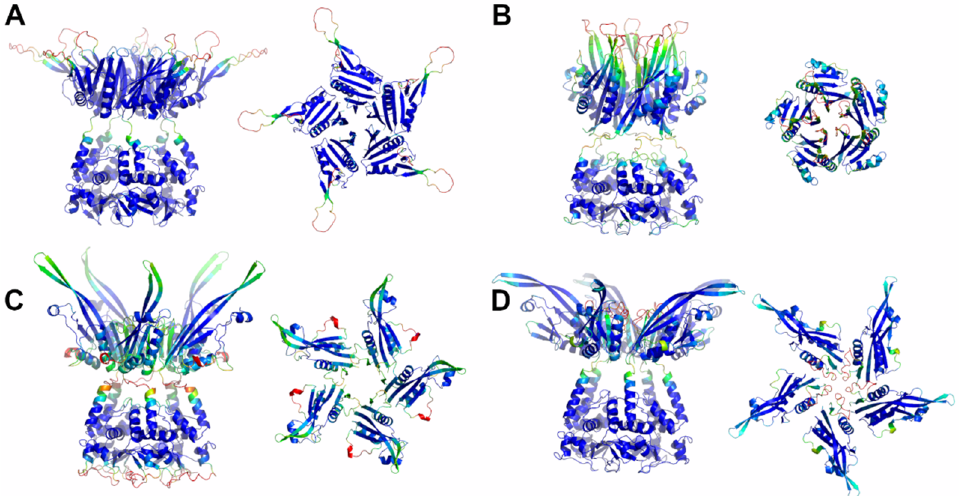
Figure 3. Schematic representation of AF full-length structures of members of Cluster 2. ( A ) KCNRG; ( B ) KCTD6; ( C ) KCTD11; ( D ) KCTD21. For each model, two views (on the left, the full-length pentameric assembly; on the right, the CTD domains only) are shown. Structural models are colored following AF per-residue confidence metric (pLDDT).